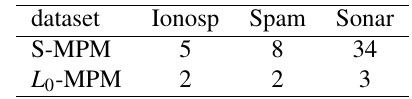
Table 7. Comparison of the number of iterations between L 0 - MPM and